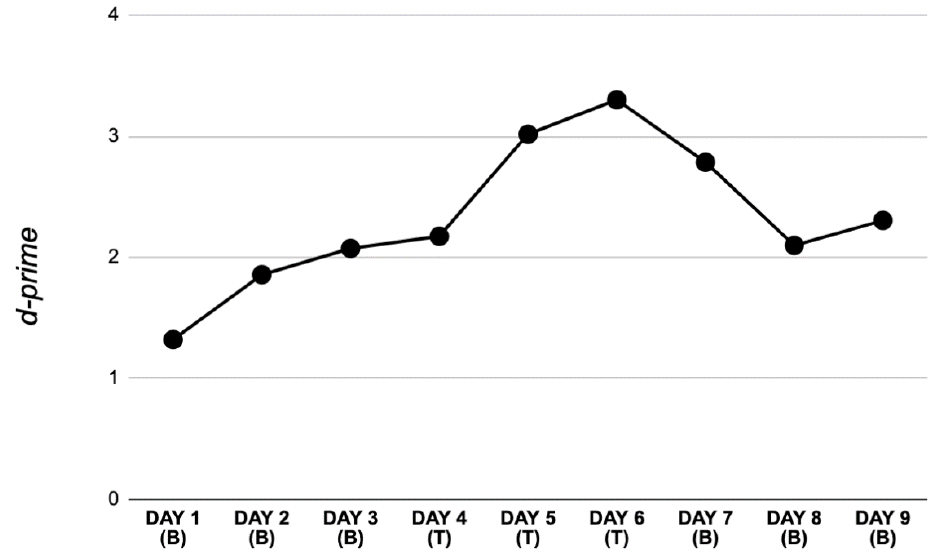
Figure 1. Performance of a subject discriminating between suspicious and non-suspicious email with (days 4 to 6) and without (days 1 to 3 and 7 to 9)